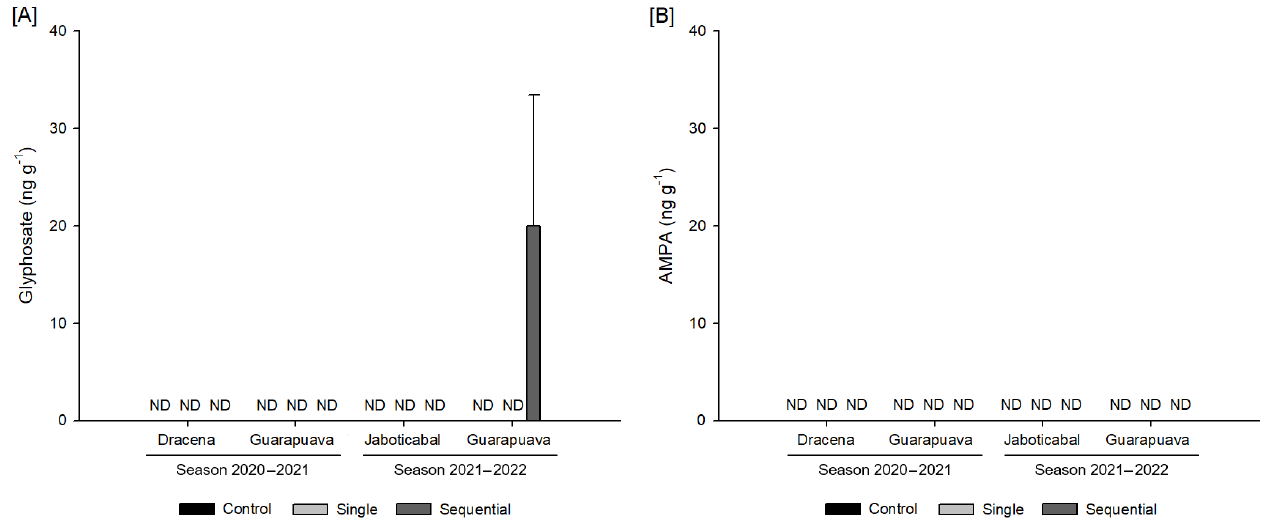
Figure 6. Content of glyphosate ( A ) and AMPA ( B ) in grain tissues of GR maize grown with no herbicide application (control), with a single application of glyphosate at 980 g of a.e. ha −1 at stage V5 (single) and a sequential application of glyphosate at 520 + 980 g of a.e. ha −1 at stage V3 and stage V7, respectively (sequential), in different locations and seasons. ND = non-detected. Error bars are one SE of the mean from ten replicates.